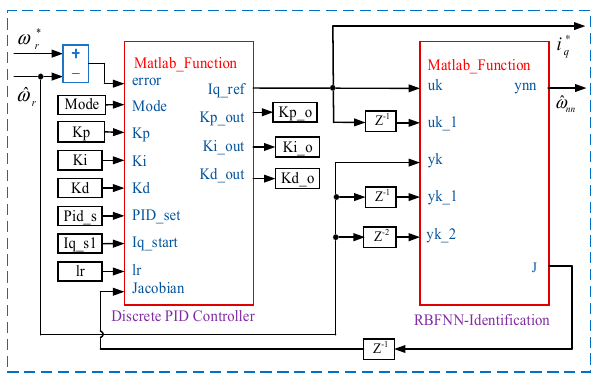
Figure 6. The block diagram of PID and RBFNN based on MATLAB function.